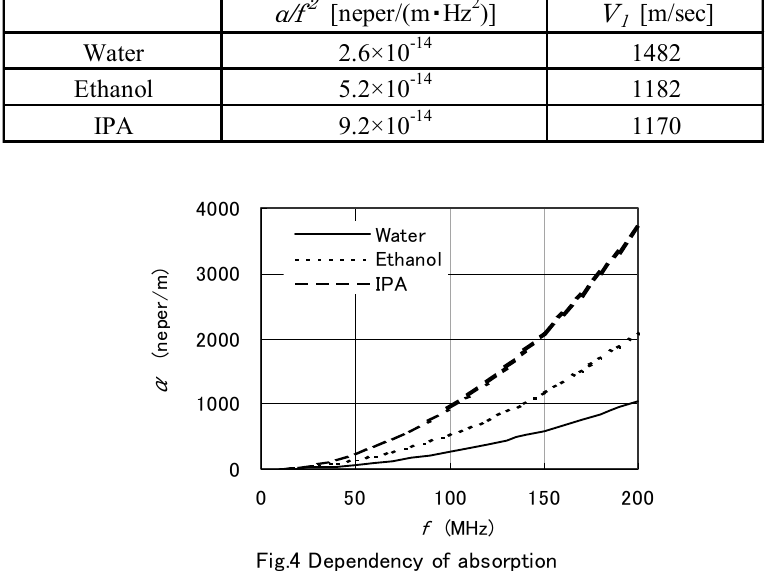
Fig.4 Dependency of absorption Coefficient on Burst